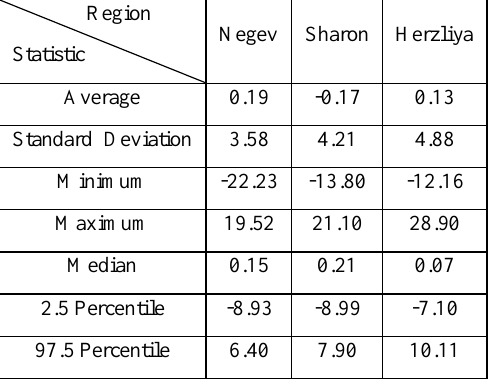
Table 1. Height comparison results